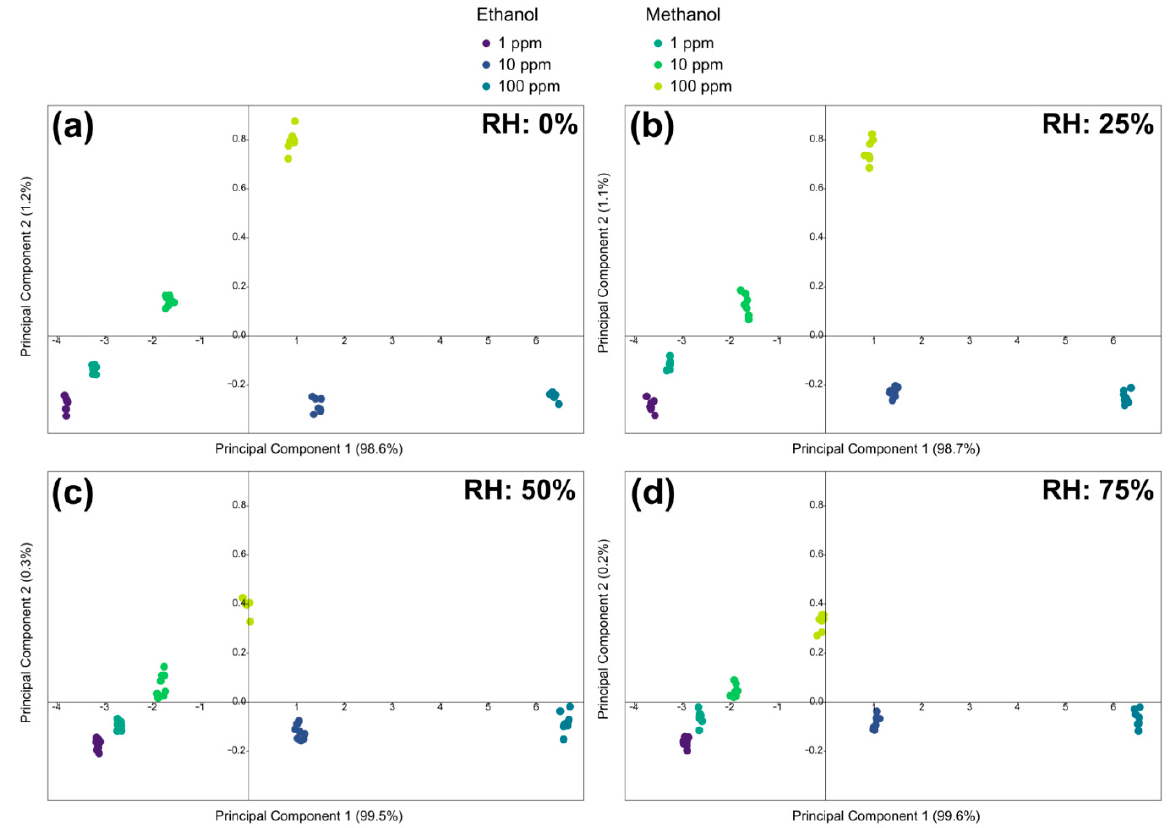
Figure 5. Plots of the principal components for concentrations of 1, 10, and 100 ppm of ethanol and methanol at ( a ) 0%, ( b ) 25%, ( c ) 50%, and ( d ) 75% relative humidity. At the bottom, from left to right, there are the concentrations of ethanol (1, 10, and 100 ppm), while from the bottom left, going up diagonally, there are the concentrations of methanol, in the same order. In Figure 5b, there are the points obtained at 25% RH, in Figure 5c those at 50% RH, and in Figure 5d those at 75% RH. The arrangement of the point groups is roughly always the same. To better compare the performance under various humidity conditions, the graphs were made with the same dimensions. The distribution of the groups of points is similar in the four graphs, but it can be noticed how, as the relative humidity increases, the groups of points tend to become closer. On the one hand, the points relating to the highest con- centrations of ethanol move upwards slightly, closing the gap with those of methanol. On the other hand, the points relating to methanol at higher concentrations drop a lot towards those of ethanol and towards the lower concentrations on the left. Qualitatively, this shows that the discrimination between the various concentrations of the various gases becomes a little more difficult. Unfortunately, PCA plots are purely qualitative and influ- enced by the perception of the human eye. To obtain a less subjective idea of the sensor performance, linear discriminant analysis was applied, the results of which are shown in Table 1.